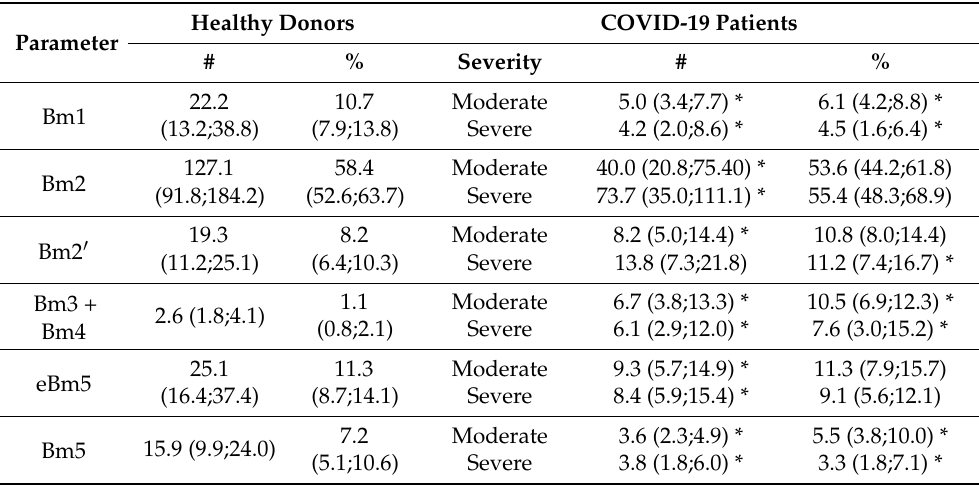
Table 3. Absolute and relative numbers of B-cell subsets identified using the “Bm1-Bm5” classification in patients with COVID-19 and healthy